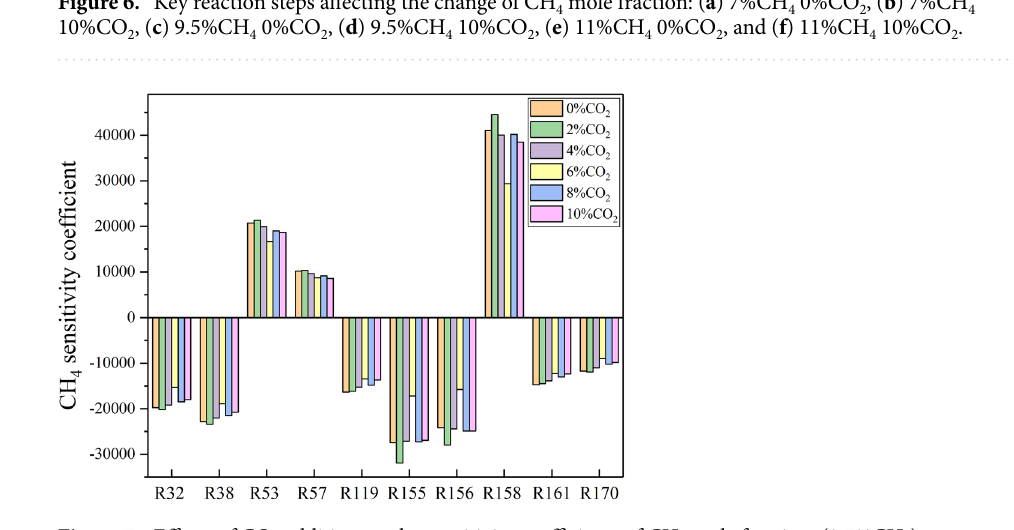
Figure 7. Effects of CO 2 addition on the sensitivity coefficients of CH 4 mole fraction. (9.5%CH 4